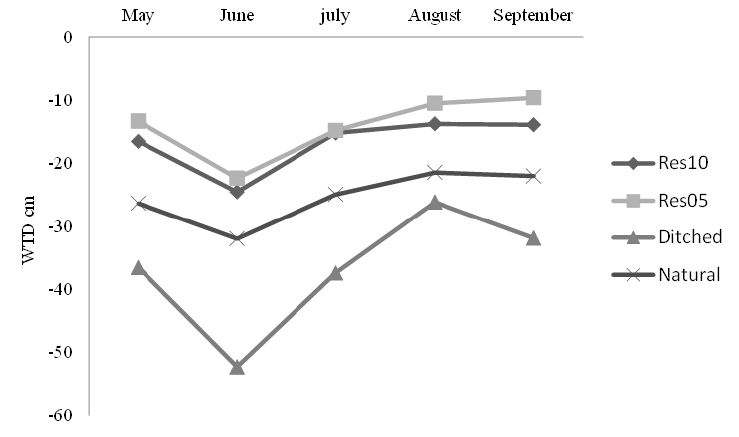
Figure 4. Monthly water table depth variation in 2007. Res05: peatlands restored 3–7 years ago; Res10: peatlands restored 9–12 years ago.